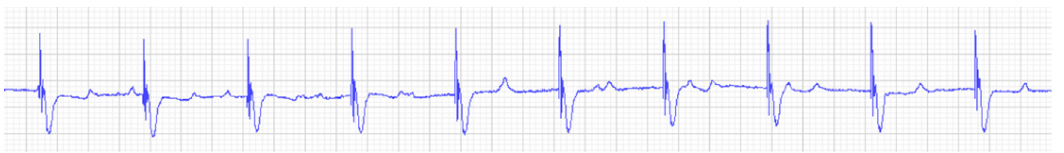
Figure 3. Base apex electrocardiogram with ventricular pacing shows regular rhythm with ventricular rate of 45 bpm. Ventricular pacing spikes precede each QRS complex (25 mm/s, 1 cm/mV).